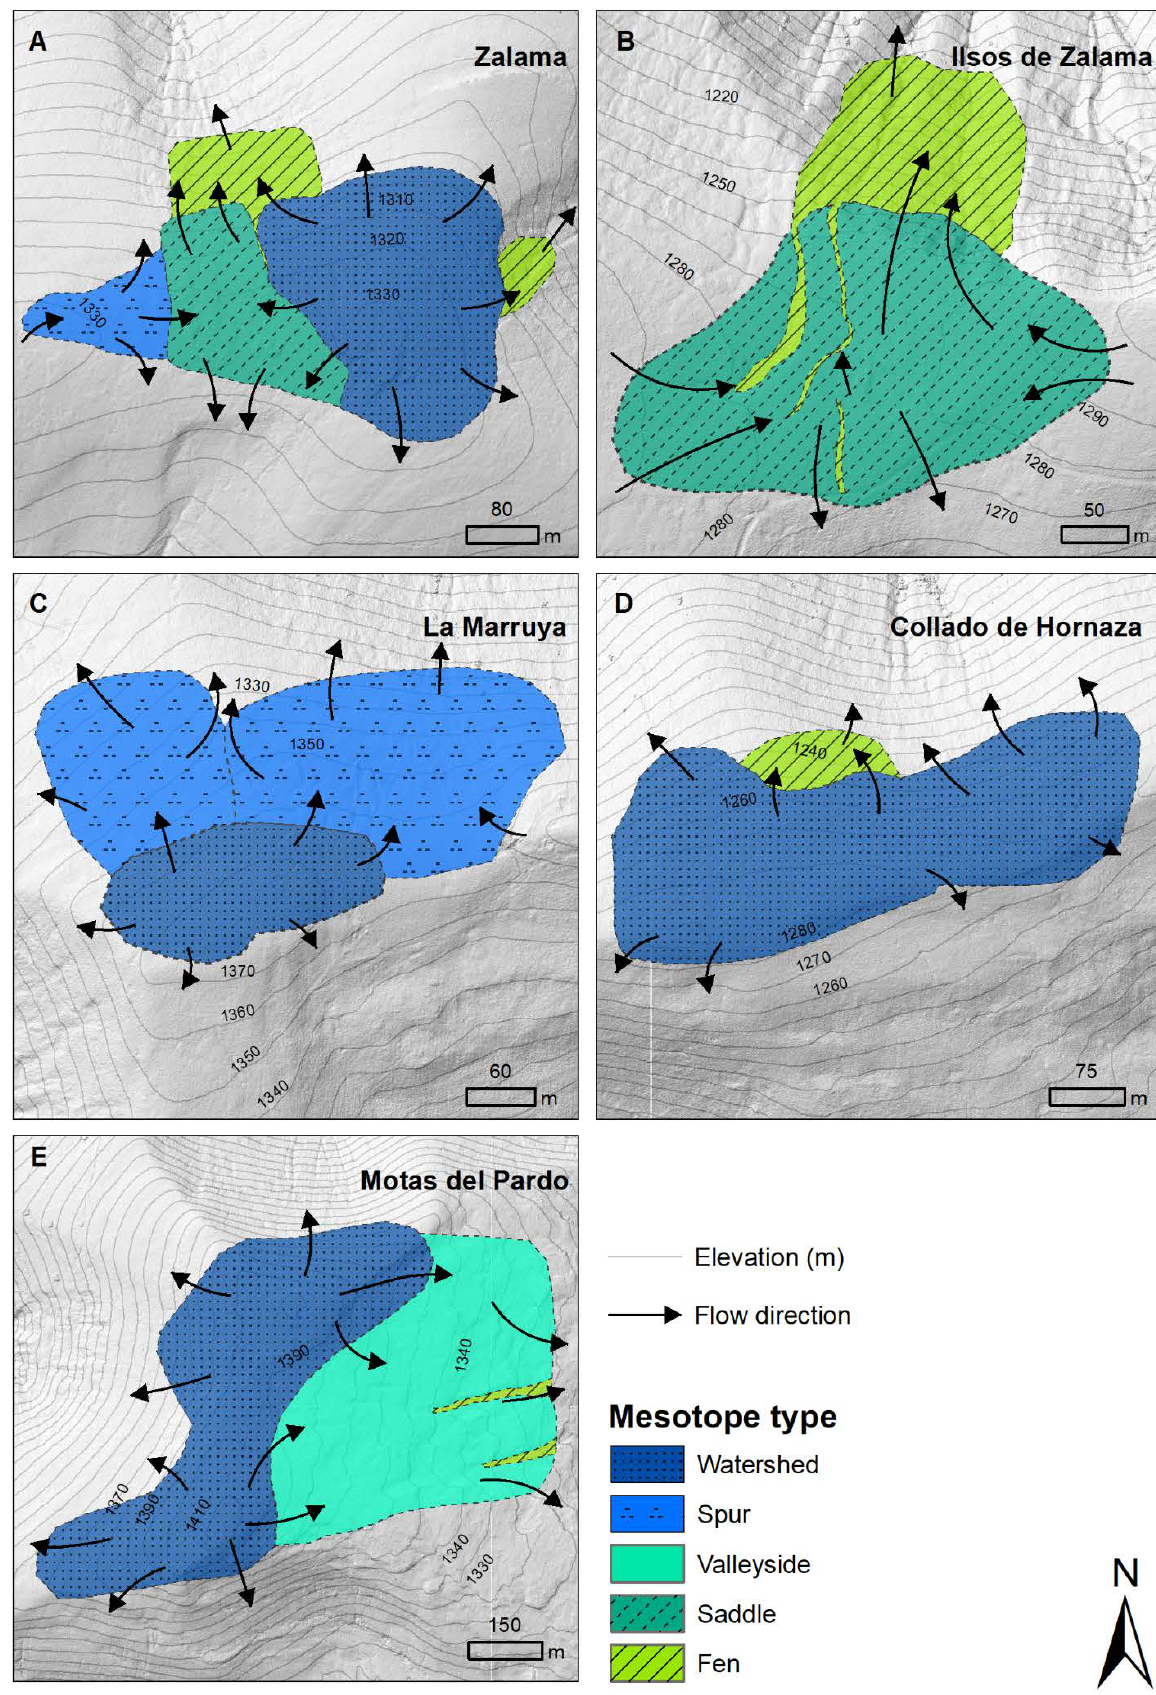
Figure 4. Mesotope units in the new blanket bogs and